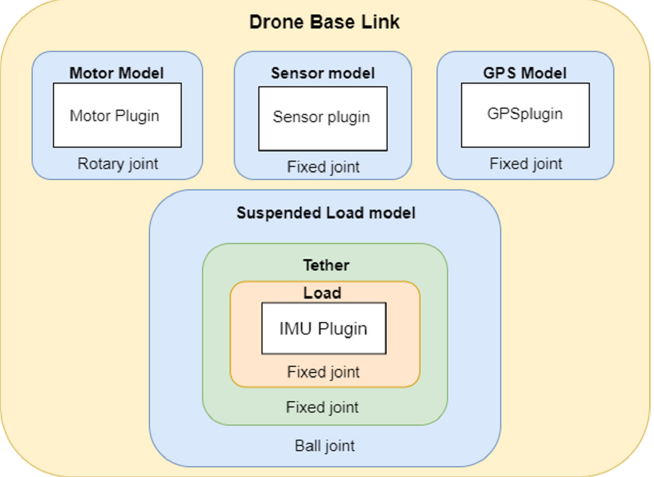
Figure 8 . Gazebo model hierarchy . Figure 8. Gazebo model